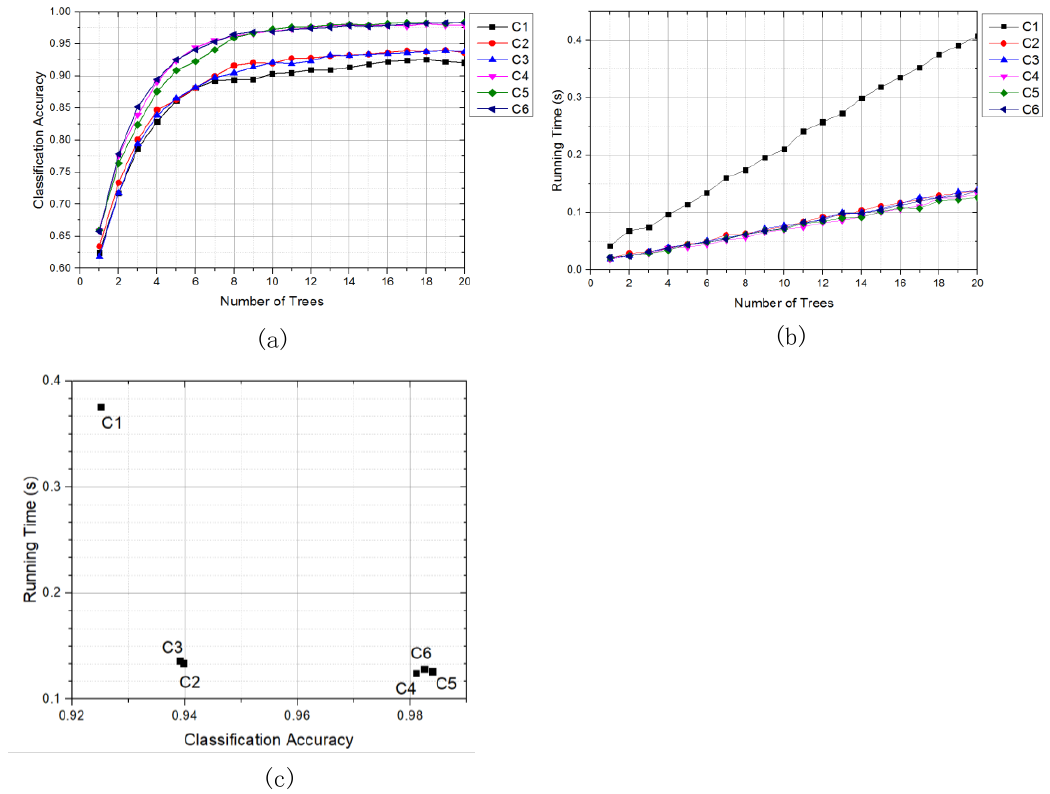
Figure 4. (a) the classification accuracy and (b) running time of Random Forest over a series of numbers of trees; (c) the relationship between running time and classification accuracy of the best performance of six feature